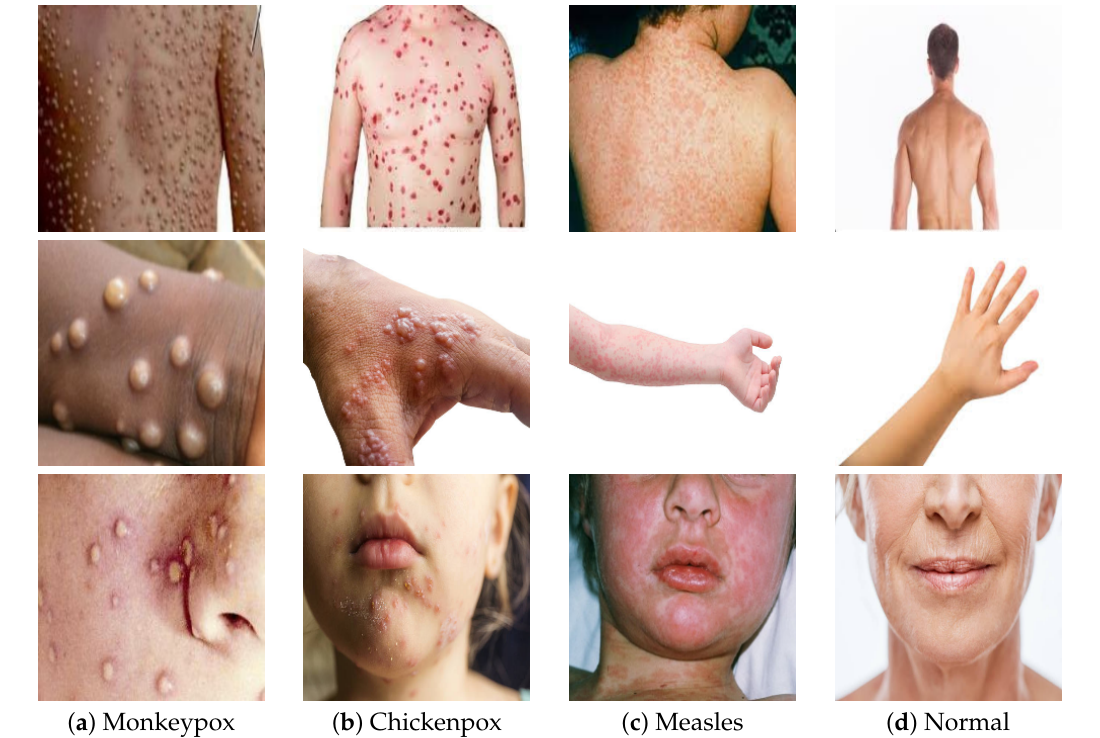
Figure 1. Samples from the Monkeypox Skin Images Dataset (MSID) [63]: ( a ) monkeypox cases, ( b ) chickenpox cases, ( c ) measles cases, and ( d ) normal cases.